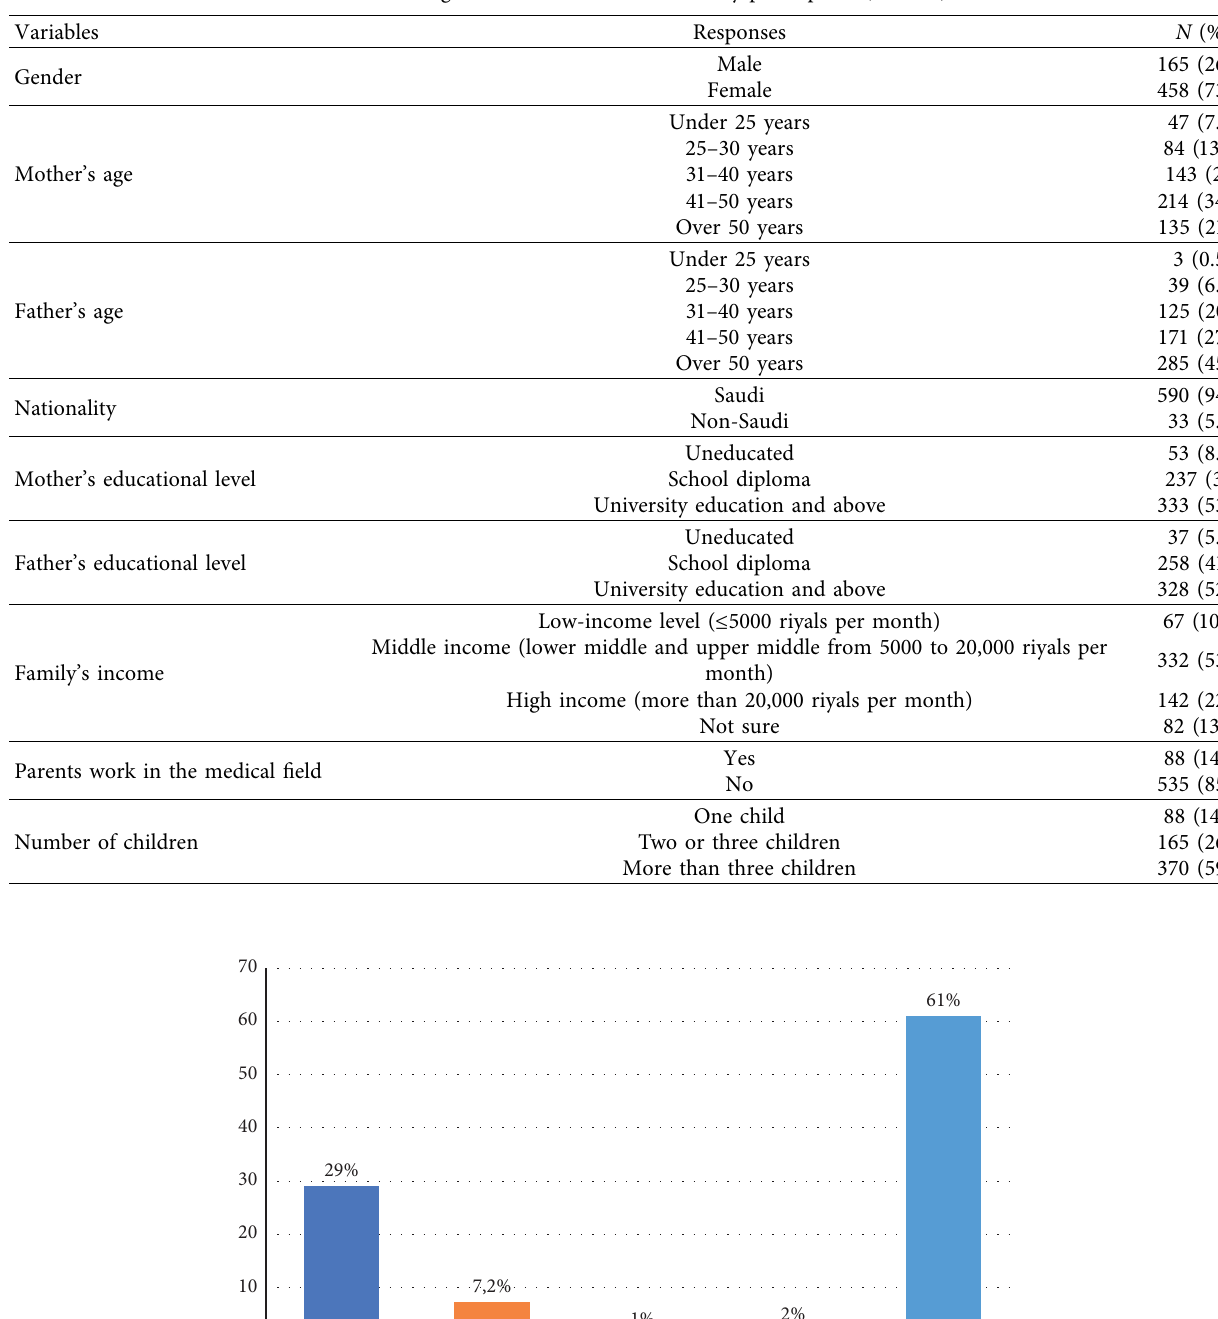
Table 1: Background information of the study participants ( N � 623).